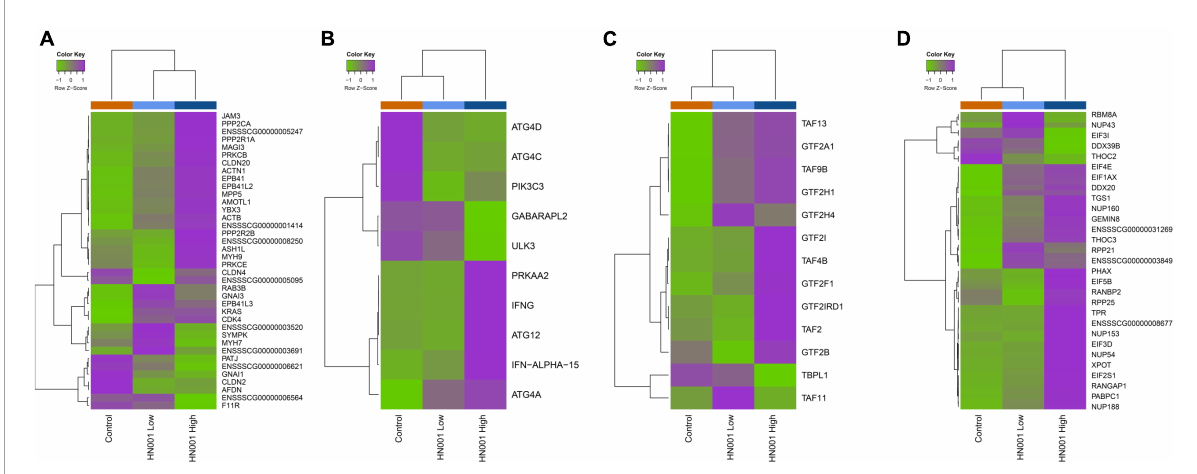
FIGURE7 Heatmaps showing mean expression profiles and hierarchical clustering of genes within the KEGG (A) tight junction , (B) regulation of autophagy , (C) basal transcription factors , and (D) RNA transport pathways. Color ribbon across top of heatmap indicates sample treatment group; Control (orange), HN001 Low (light blue), and HN001 High (dark